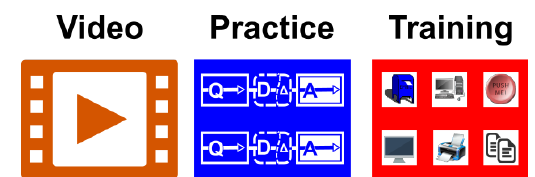
Fig. 6. Schematic diagram of an E-AMS typical lesson